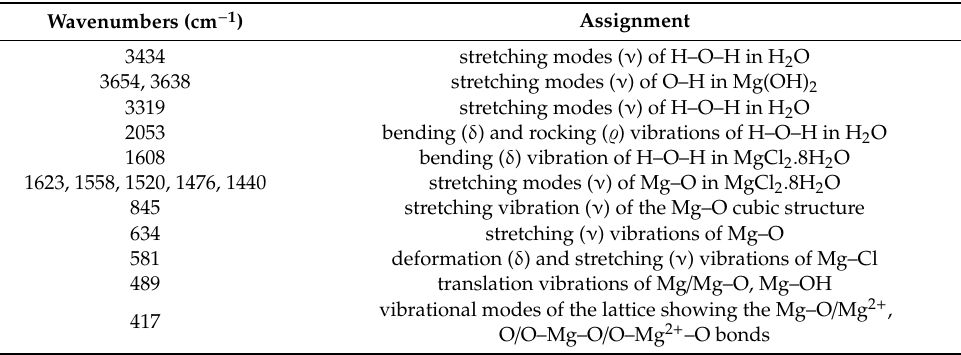
Table 1. Assignments of the major absorption